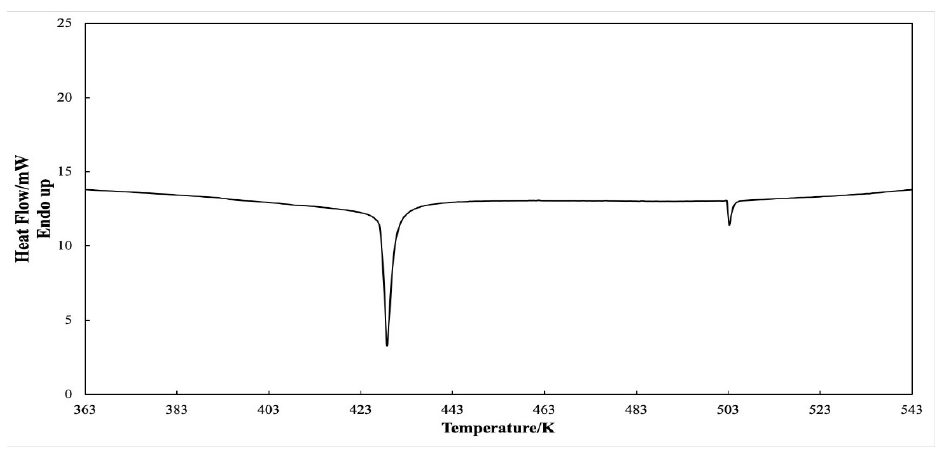
Figure 6. DSC curve of the anode for a new cell.